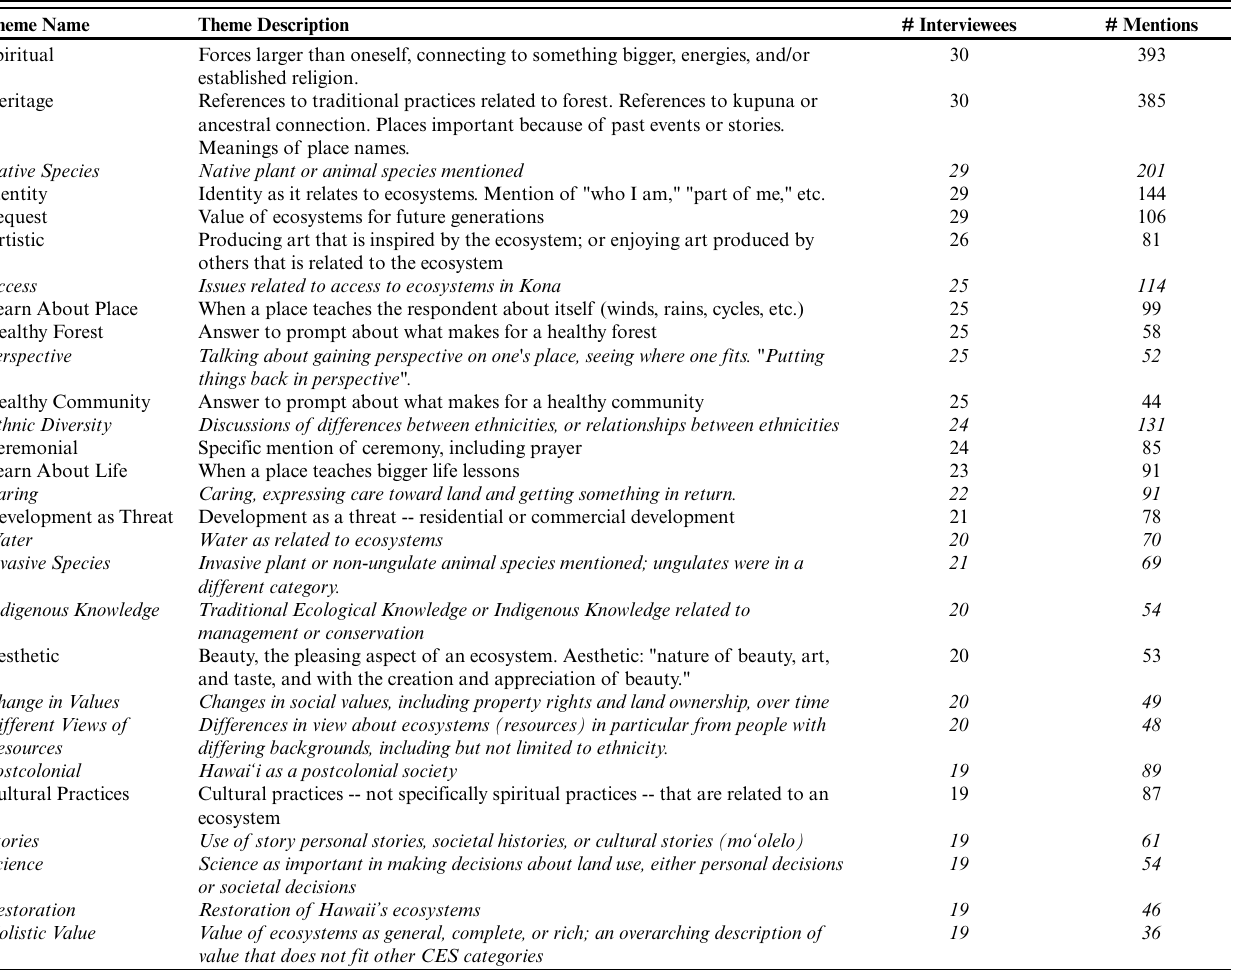
Table 2 . Themes addressed by at least half of interview respondents (including responses to specific questions). Rows in italics are themes that were not specifically prompted in interviews. We elaborate on the theme of perspective in Gould et al.